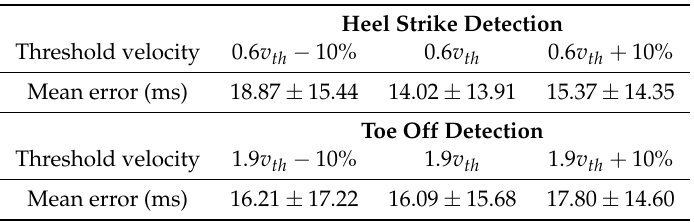
Table 9. Sensitivity analysis on the threshold velocities used for the gait event detection.